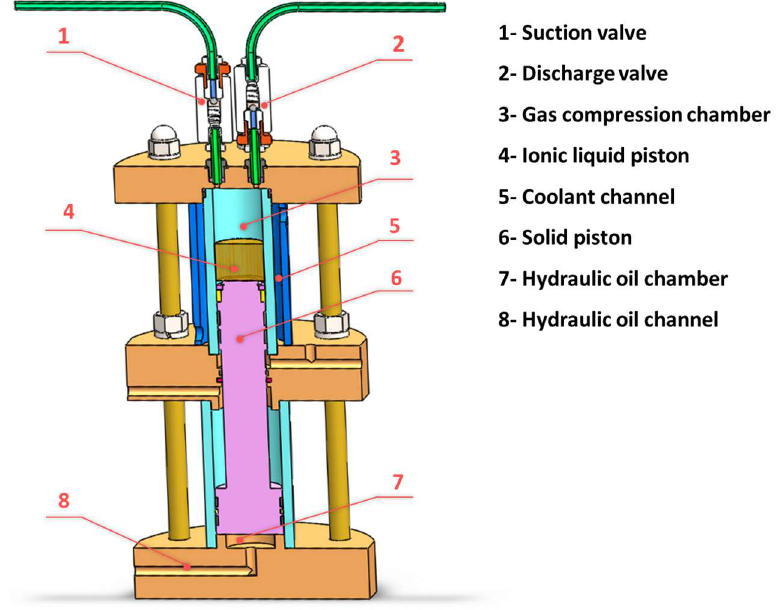
Figure 1. Methodology of density selection for the hydrogen compressor design.